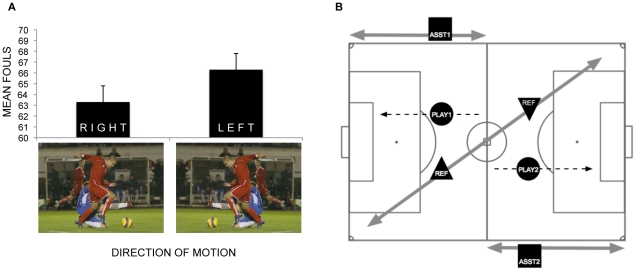
Average number of fouls called with two example stimuli and the standard left diagonal system of control.(A) The mean number of fouls called is greater for left-moving pictures. (B) In the left diagonal system, the referee (REF) will generally observe a play (PLAY1 & 2) unfold from right-to-left in the attacking third of the field. For the assistants (ASST1 & 2), attacking play will always unfold from left to right. These opposing perspectives should lead to referees having a lower threshold for making fouls calls relative to assistants in the attacking half of the field.